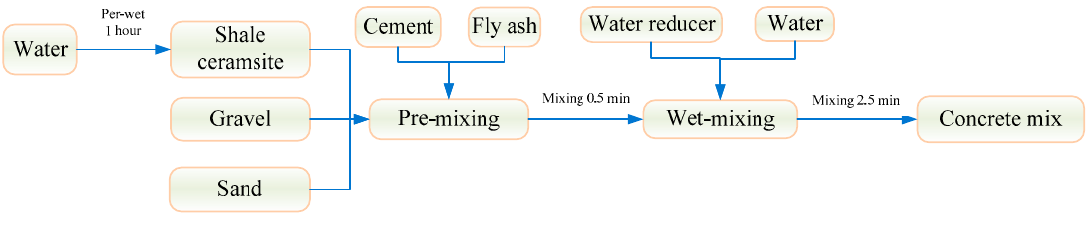
Figure 2. Forming process of concrete.